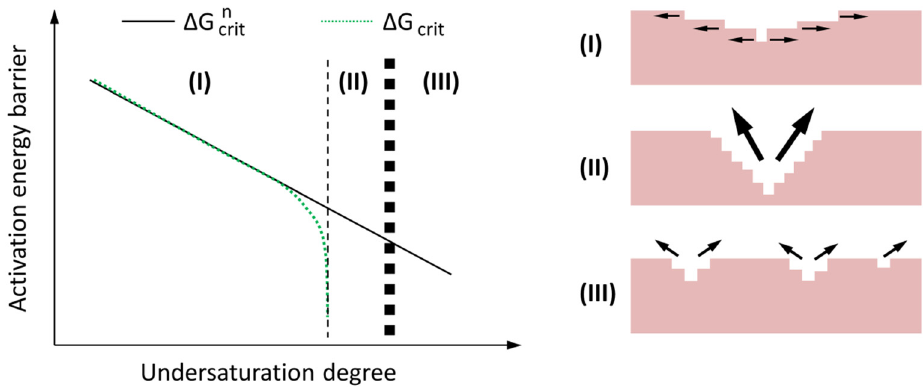
Figure 11. Schematic illustration of the two activation energy barriers ∆ G crit n (vacancy islands) and ∆ G crit (etch pit) as a function of the undersaturation degree. (after [54]).